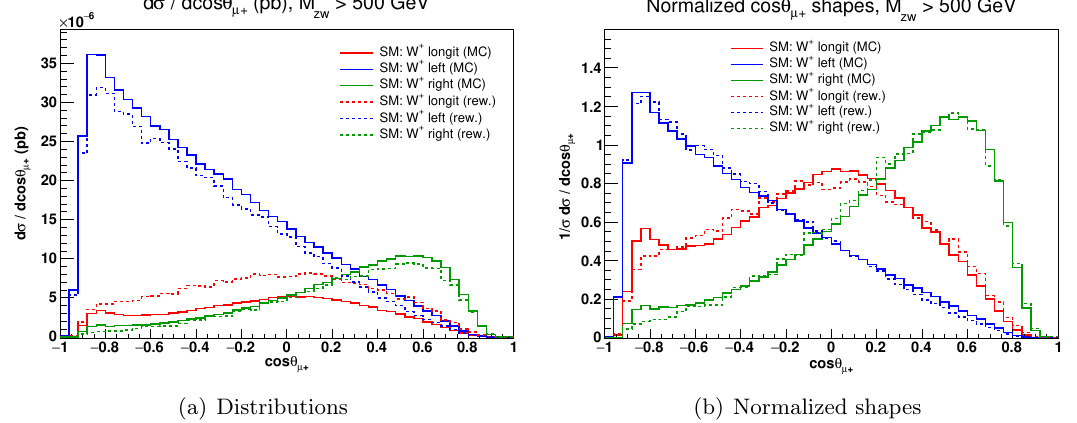
Figure 10 . W + Z scattering: polarized cos (cid:18) distributions in the region M WZ > 500 GeV. (cid:22) + Results of the reweighting procedure compared with results of the MC calculation with polarized amplitudes. The full set of cuts and neutrino reconstruction are